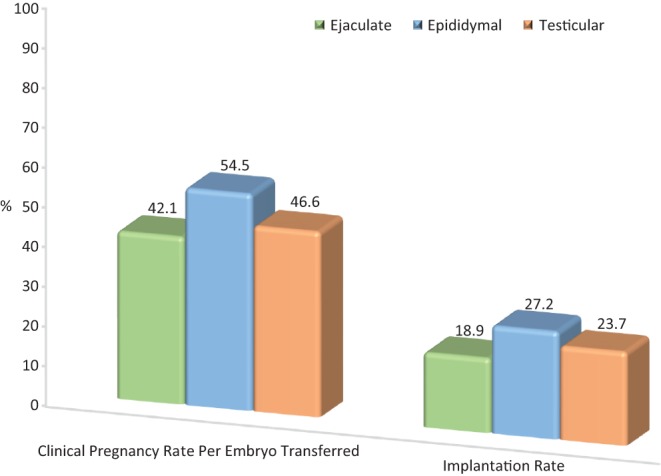
Comparison of pregnancy and implantation rates according to spermatozoa source. Embryos generated from epididymal spermatozoa had the highest pregnancy rate followed by testicular and ejaculated spermatozoa (χ2, 2 × 3, 2df; P < 0.0001). Embryo implantation rate was highest with epididymal, followed by testicular and ejaculated specimen (χ2, 2 × 3, 2 df; P < 0.0001).